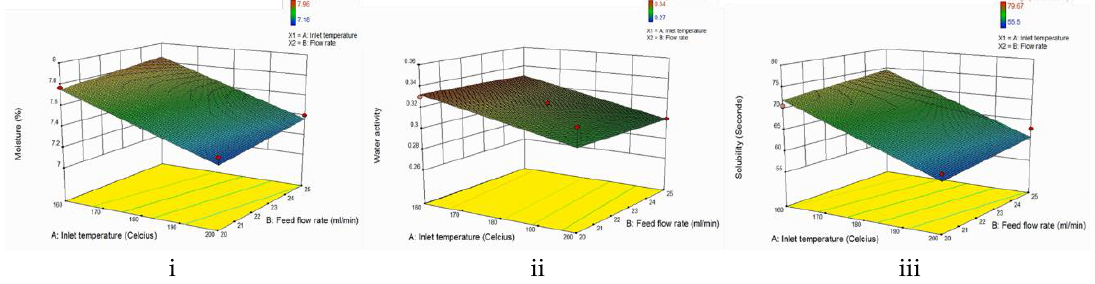
Figure 2. Three-dimensional surface plot of the effect of inlet temperature and feed flow rate to the ( i ) moisture content, ( ii ) water activity, ( iii ) solubility of powder. moisture content, ( ii ) water activity, ( iii ) solubility of